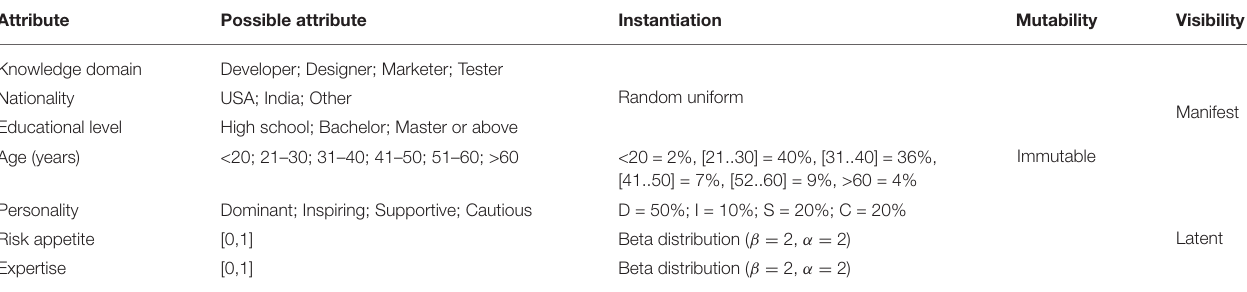
TABLE 1 | Worker attributes observing their mutability, visibility, type, possible value, and